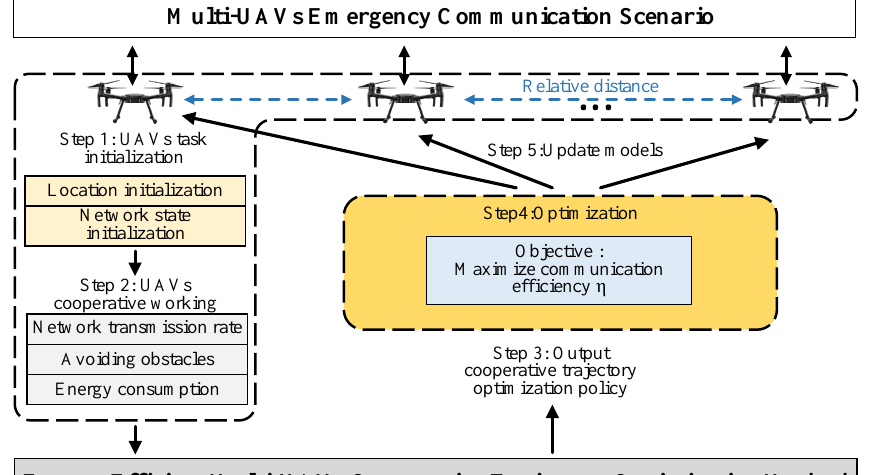
Figure 2. The flowchart of the DSAAC